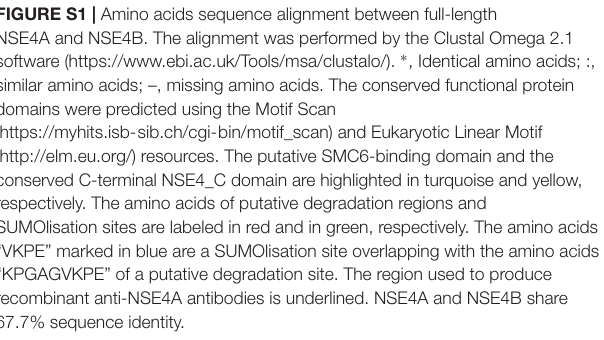
FIGURE S1 | Amino acids sequence alignment between full-length NSE4A and NSE4B. The alignment was performed by the Clustal Omega 2.1 software (https://www.ebi.ac.uk/Tools/msa/clustalo/). ∗ , Identical amino acids; :, similar amino acids; –, missing amino acids. The conserved functional protein domains were predicted using the Motif Scan (https://myhits.isb-sib.ch/cgi-bin/motif_scan) and Eukaryotic Linear Motif (http://elm.eu.org/) resources. The putative SMC6-binding domain and the conserved C-terminal NSE4_C domain are highlighted in turquoise and yellow, “VKPE” marked in blue are a SUMOlisation site overlapping with the amino acids “KPGAGVKPE” of a putative degradation site. The region used to produce recombinant anti-NSE4A antibodies is underlined. NSE4A and NSE4B share 67.7% sequence identity. FIGURE S2 | Proof of the NSE4A antibody specificity. (A) Western blots showing the correct size ( ∼ 28 kDa) of the expressed recombinant NSE4A protein. The purified NSE4A proteins (1: 1.4 µ g, 2: 1.4 µ g, 3: 0.7 µ g) were separated on a 10% SDS-PAA gel, stained with Coomassie Blue (1) or